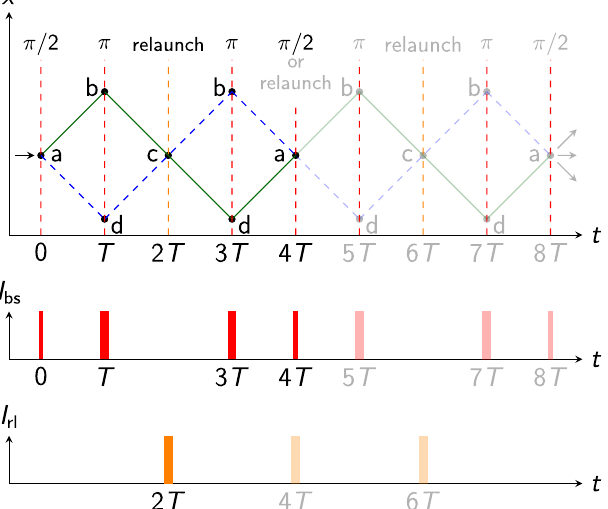
Figure 2. Space-time diagram and pulse timings of a multi-loop interferometer. The upper diagram shows the timing of the π/ 2 beam splitting at position (a) in Fig. 1, π mirror pulses at position (b) and (d) in Fig. 1, and relaunch at position (c) in Fig. 1 as well as the recombination ( π/ 2 ) pulse at (a). Non-opaque lines indicate an 1 ) and opaque lines a four-loop interferometer ( n implementation with the minimum of two loops ( n = The interferometer can be extended to 2 n loops closed with a π/ 2 pulse at 4 nT by introducing relaunches at r 4 T for r 1 ) (position (a) in Fig. 1). The lower diagram shows the time-dependent intensities ( 1, 2, . . . , n · ∈ − of the beam splitting pulses I bs and relaunches I rl . Diagrams are not to scale, neglect pulse shaping and the initial launch before the atoms enter the